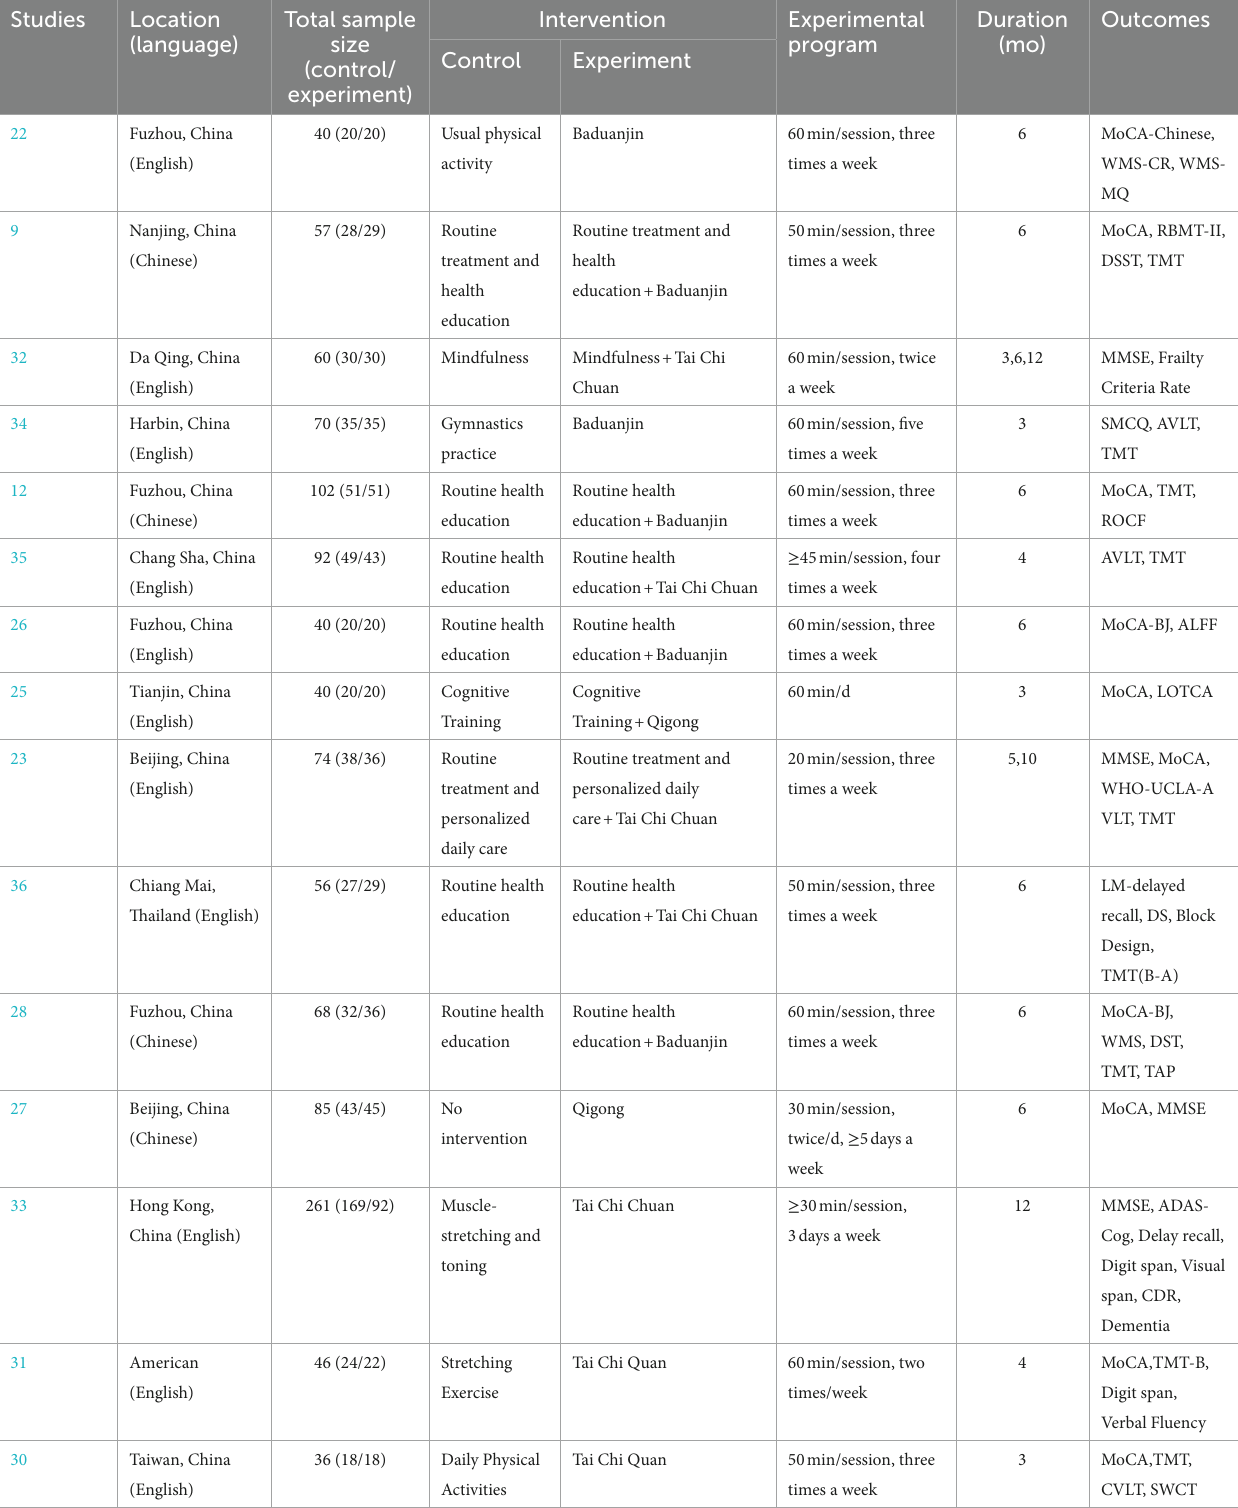
TABLE 1 Characteristics of the included